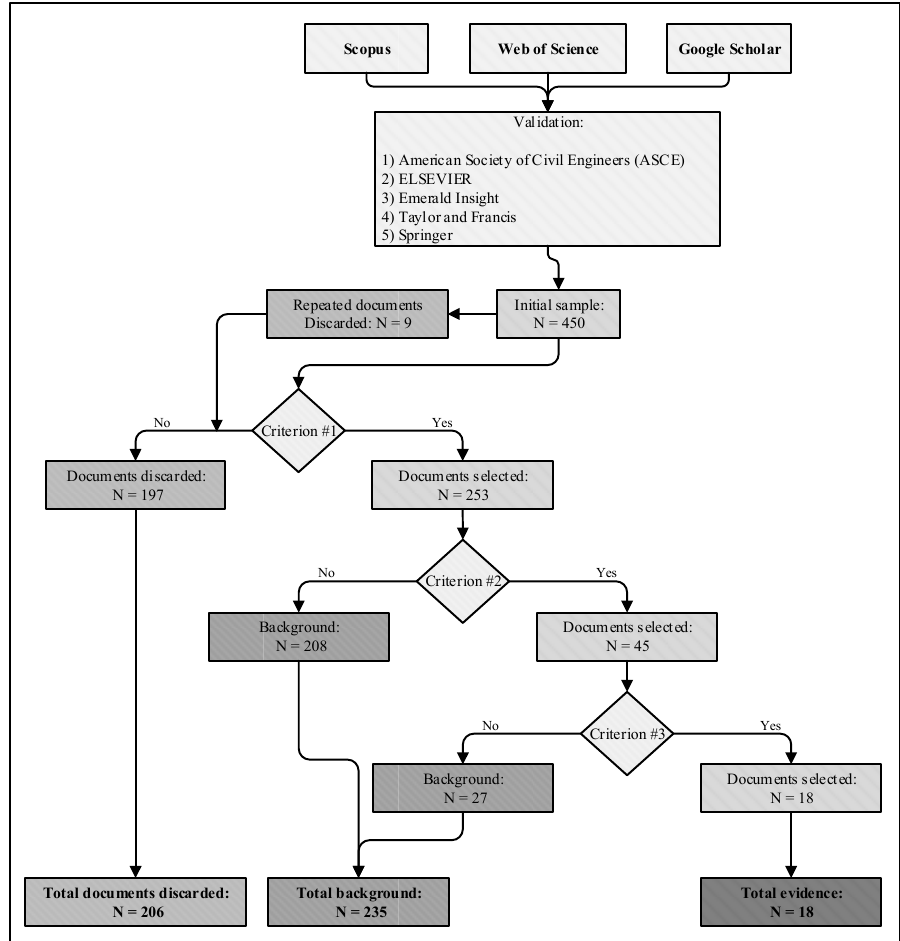
Figure 2. Document flow in the document selection stage.